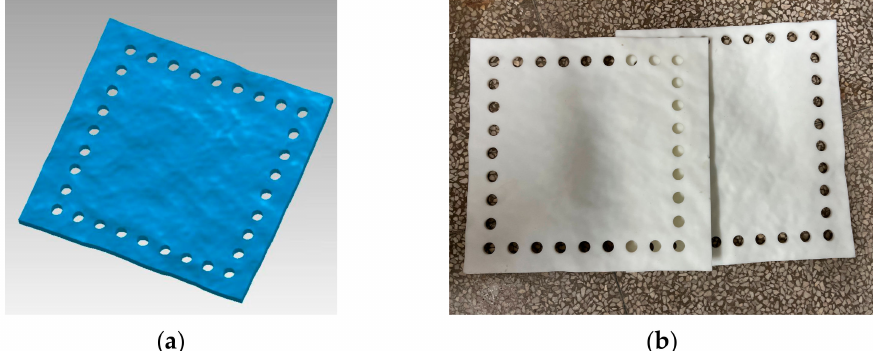
Figure 6. The fabrication of simulated structural plane. ( a ) Three-dimensional model of structural plane; and ( b ) 3D printing of simulated structural planes.